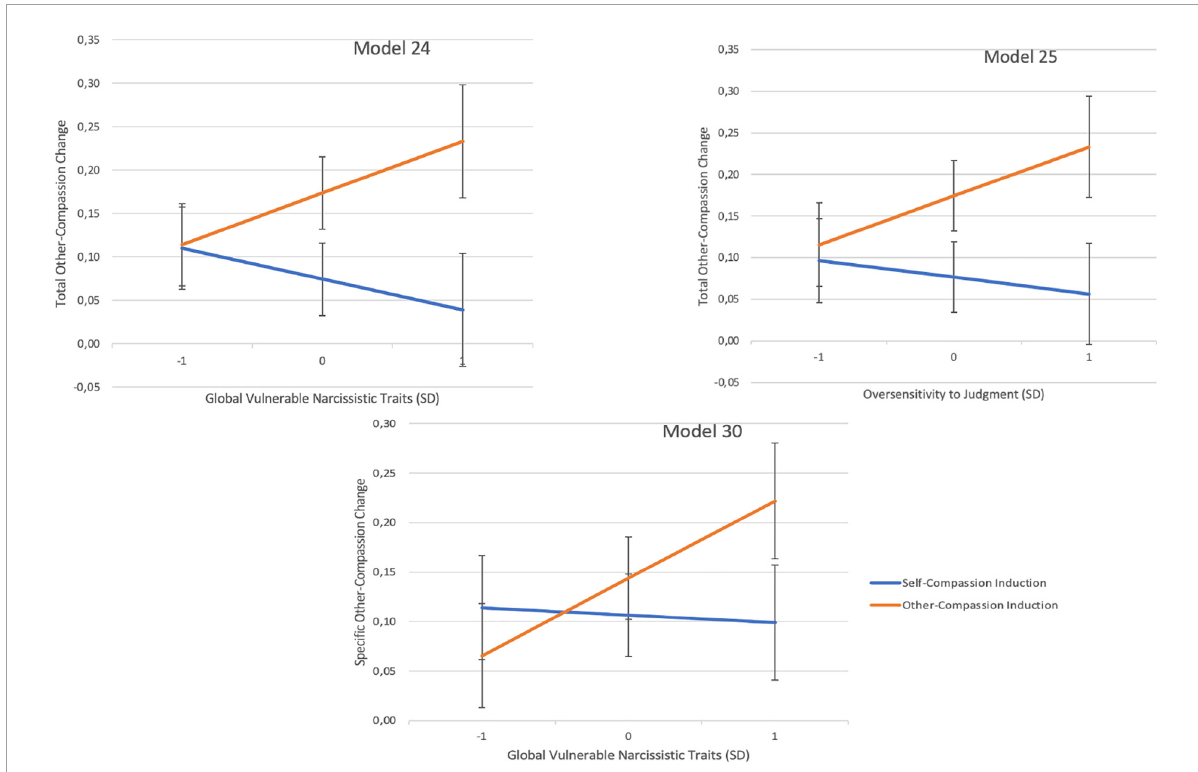
FIGURE3 Moderation regression interaction plots; displaying the average other-compassion change scores for pick-a-point values (SD) of vulnerable narcissistic traits for each induction type. The y -axis represents the pre-to-post induction OC change scores. Change scores of zero indicate no improvement or worsening. The higher the value on the y -axis, the larger the improvement. The error bars represent the standard